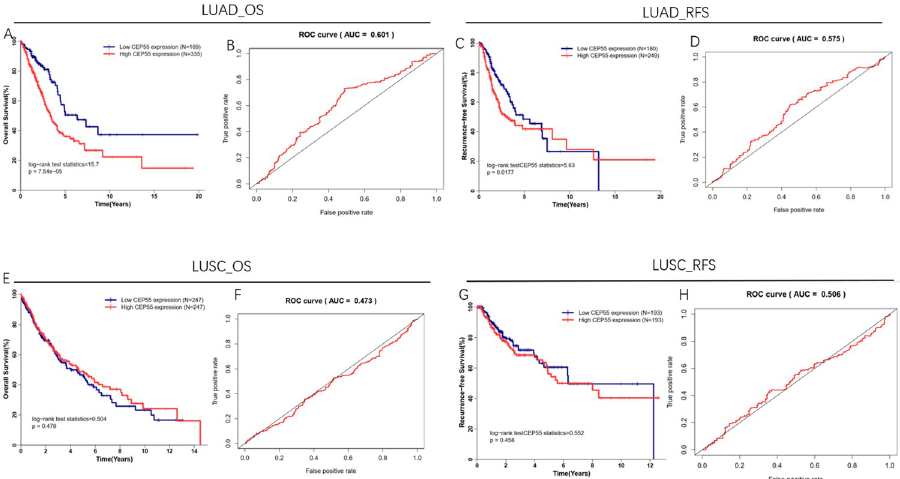
Fig 3. The correlation between CEP55 expression and the OS and RFS of patients. A: The correlation between CEP55 expression and the OS of LUAD patients; B: ROC curve for evaluating OS by CEP55 in LUAD patients; C: The correlation between CEP55 expression and the RFS of LUAD patients; D: ROC curve for evaluating RFS by CEP55 in LUAD patients; E: The correlation between CEP55 expression and the OS of LUSC patients, F: ROC curve for evaluating OS by CEP55 in LUSC patients; G: The correlation between CEP55 expression and the RFS of LUSC patients; H: ROC curve for evaluating RFS by CEP55 in LUSC patients.